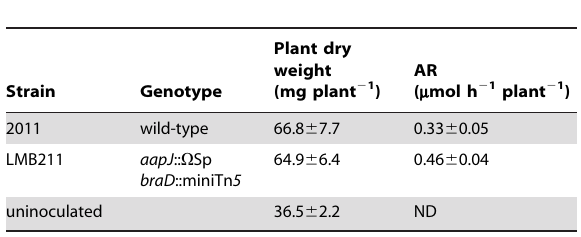
Table 7. Plant dry weights and acetylene reduction (AR) of alfalfa ( M. sativa ) at 4